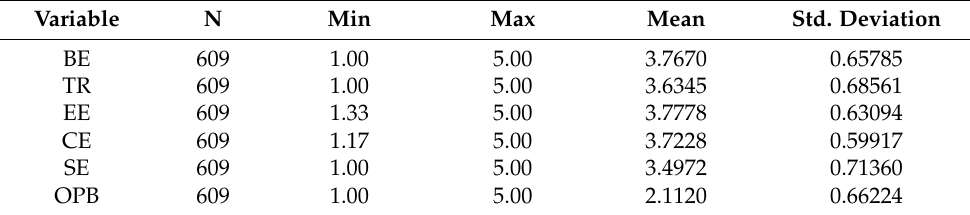
Table 5. The results of the descriptive statistical analysis of the variables’